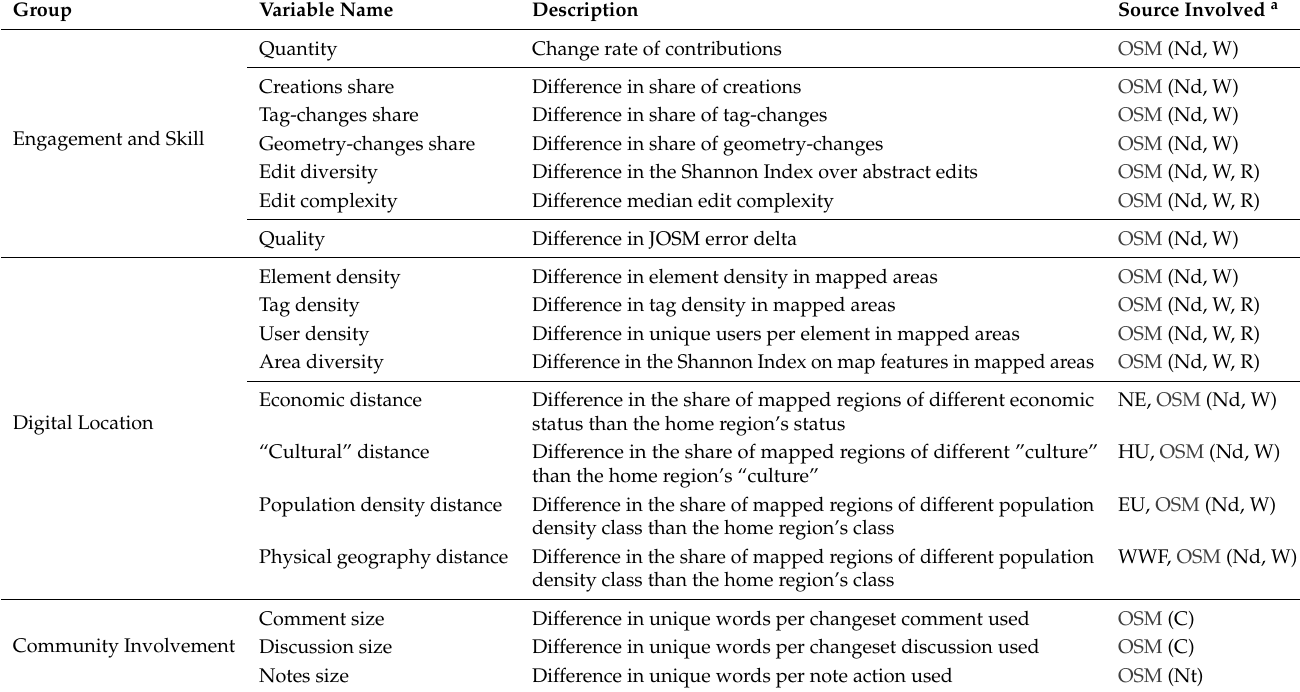
Table 2. Overview of measured proxy variables. See Section 2.3 for an explanation of the variables, Section 2.4 for an overview of the involved data sources and Section 2.5 for a detailed explanation on the calculation of the variables. The description in this table refers to the implementation for advanced mappers. Absolute values instead of differences and the change rate were calculated for